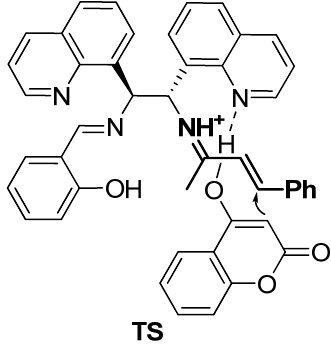
Figure 5. Plausible transition state (TS)